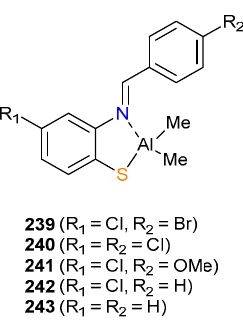
ff bases 239–243